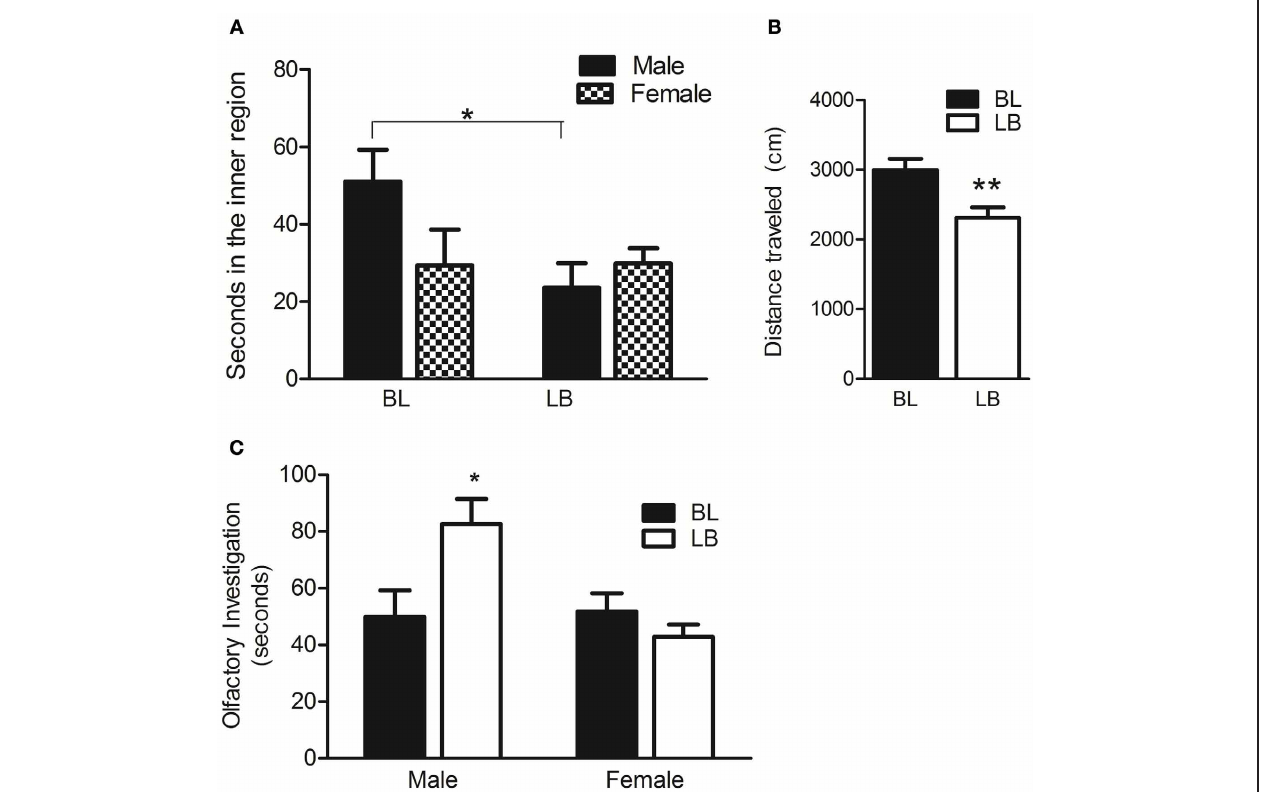
FIGURE 5 | Behavioral phenotypes indicate that LB animals have heightened anxiety in a novel environment but not during social interaction with a juvenile. (A) LB males show heightened anxiety by spending less time in the inner region of the open field test than BL males. N = 9 LB males, N = 6 LB females; N = 5 BL males, N = 6 BL females. (B) LB animals traveled less total distance in the open field test compared to BL animals. (C) LB males showed a higher level of olfactory investigation of a